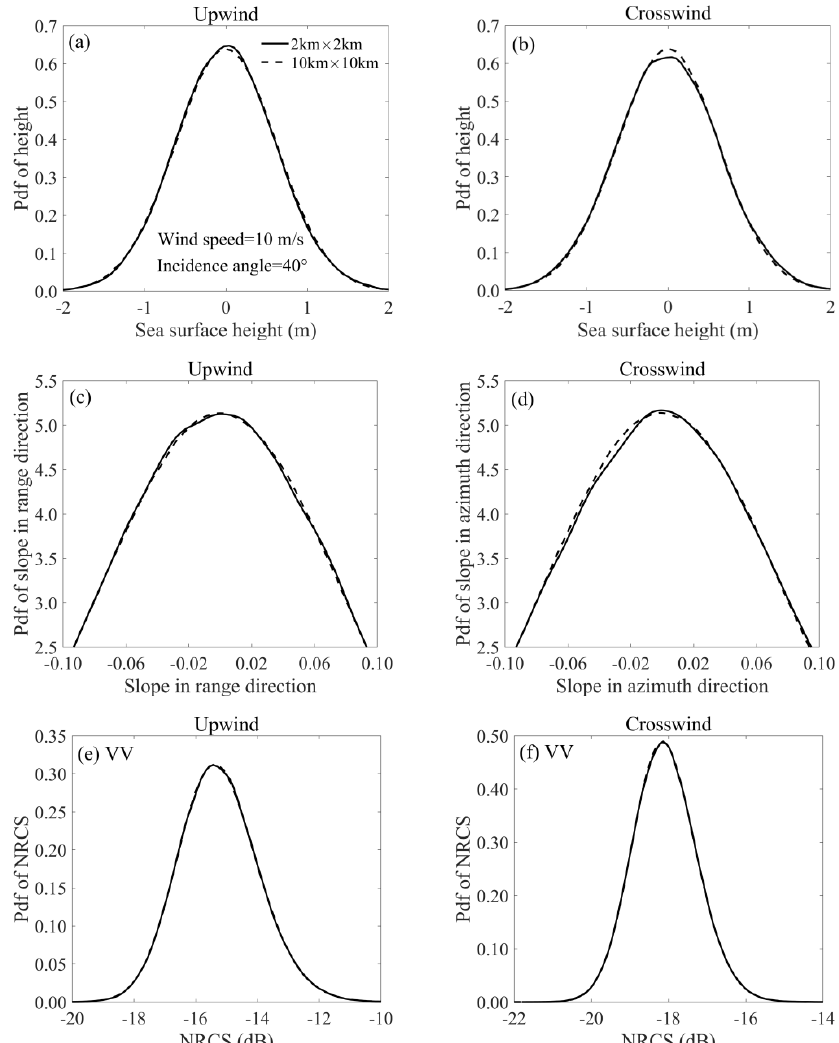
Figure 23. Comparison of the distributions of sea surface with different ocean surface sizes at the incidence angle of 40° and wind speed of 10 m/s in the upwind ( left ) and crosswind ( right ) directions. The facet resolution is 5 m × 5 m. ( a , b ) Pdfs for elevation; ( c , d ) pdfs for slope; ( e , f ) pdfs for backscatter under VV polarization. Solid curves, the size of the sea surface is 2 km × 2 km; dashed curves, the size of the sea surface is 10 km × 10 km.